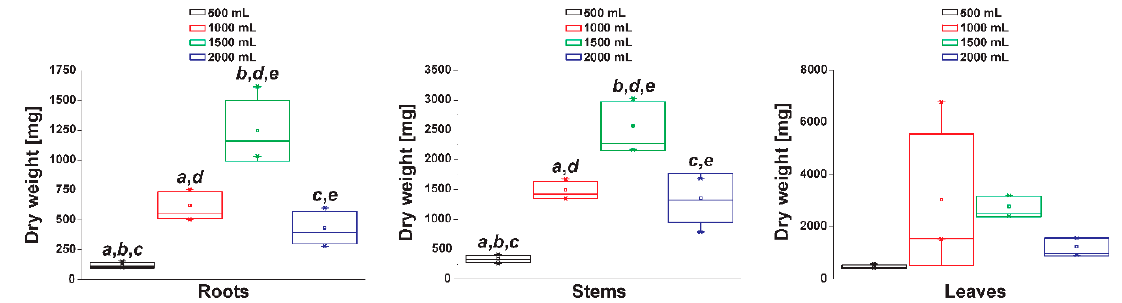
Figure 1. The dry weight of dissected Datura stramonium organs grown under di ff erent irrigations. Box plots show the standard deviation. Letters above bars represent significant pairwise di ff erences according to Tukey test (ANOVA p ≤